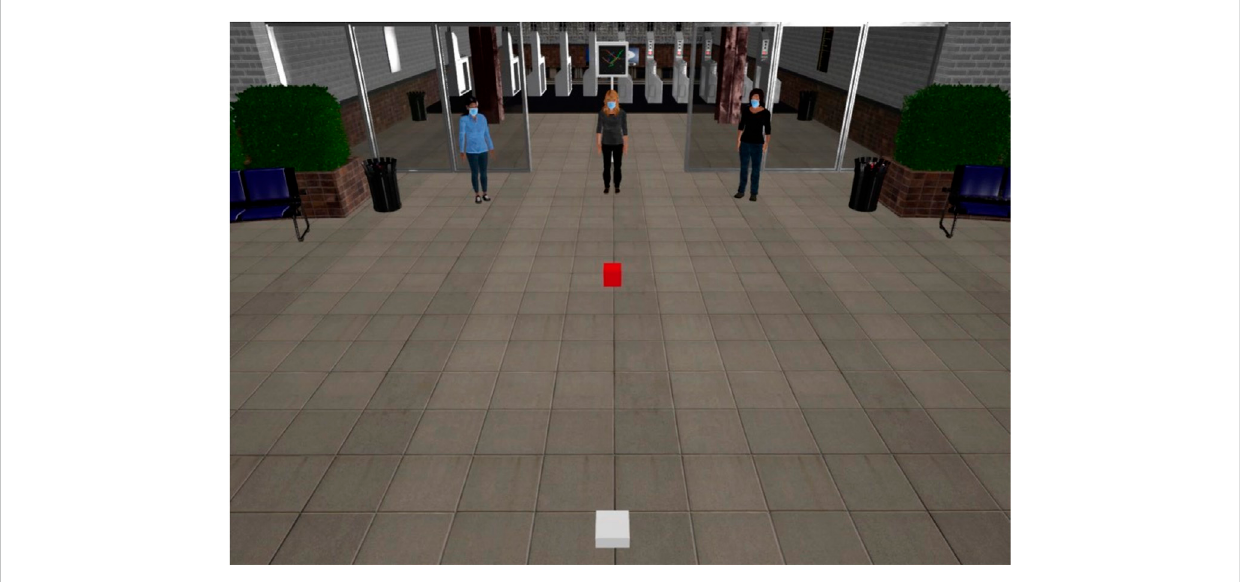
FIGURE 1 Perspectiveview ofthevirtual environment. At thestartof eachtrial, participantsstood attheinitial position (whitecube) facingthree VRPs standing in front of a subway station entrance. The TPC (red cube), while invisible to the participant, illustrates the point at which a collision would occur if no walking adjustments were